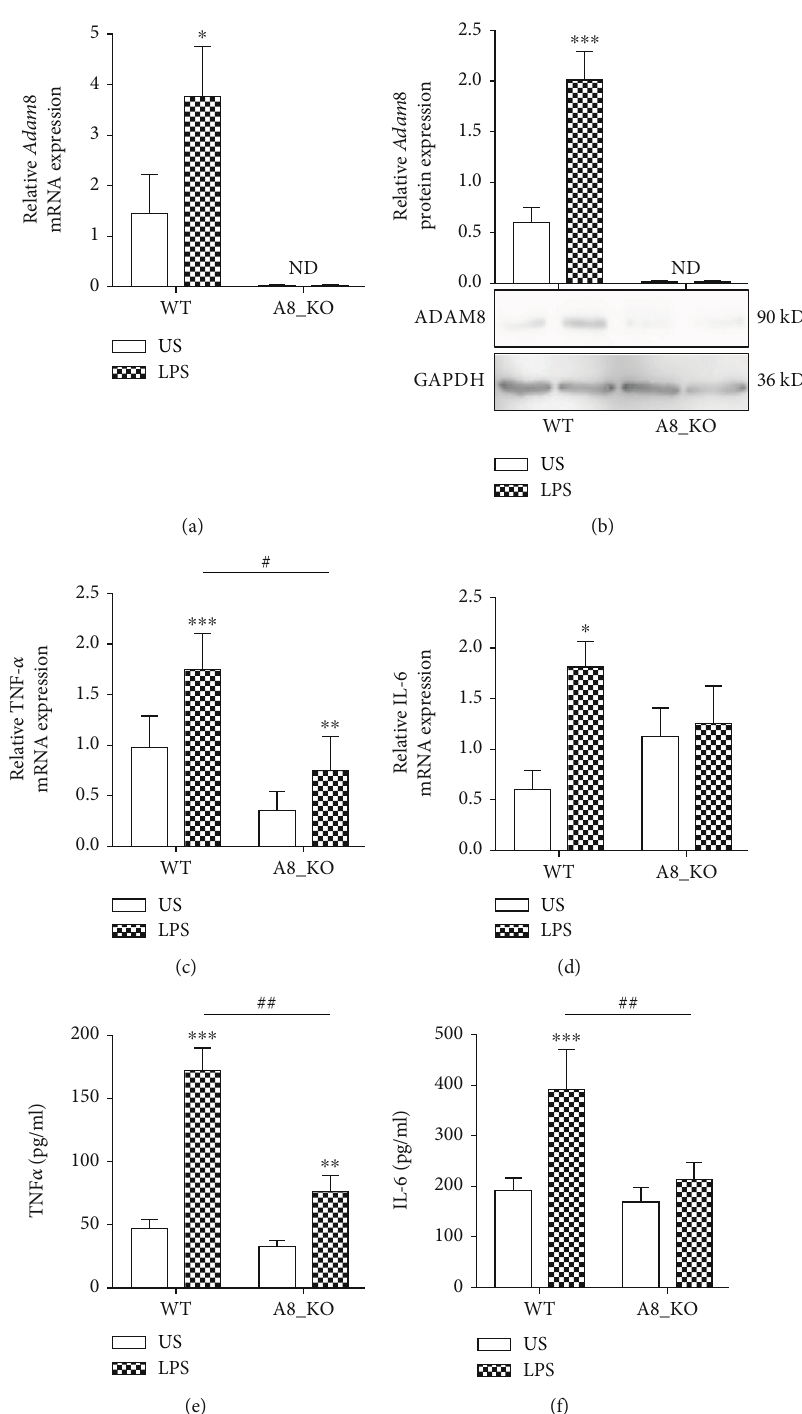
Figure 4: Reduction of LPS-induced cytokine expression and release in primary hepatocytes with ADAM8 knockout. (a – d) Primary murine hepatocytes were generated from wild-type (WT) mice or ADAM8 knockout (A8_KO) mice. Subsequently, cells were stimulated with or without LPS (1 μ g/ml) for 24 h and analysed for mRNA expression (a) and protein expression (b) of ADAM8. The data are shown as representative blot. The band intensities were quanti fi ed by densitometry and normalised to GAPDH protein expression. The mRNA expression of TNF - α (c) and IL-6 (d) was also analysed by qPCR, and all qPCR data was normalised to the mRNA expression of Rps29 . (e, f) Release of TNF- α and IL-6 in primary hepatocytes was analysed by ELISA. Quantitative data are shown as the mean + SD of 3-4 independent experiments. Signi fi cant di ff erences to the unstimulated controls are indicated by asterisks ( ∗ p < 0 : 05 , ∗∗ p < 0 : 01 , and ∗∗∗ p < 0 : 001 ). Di ff erences caused by knockout of ADAM8 compared to control are indicated by hashtags ( # p < 0 : 05 , ## p < 0 : 01 , and ### p < 0 : 001